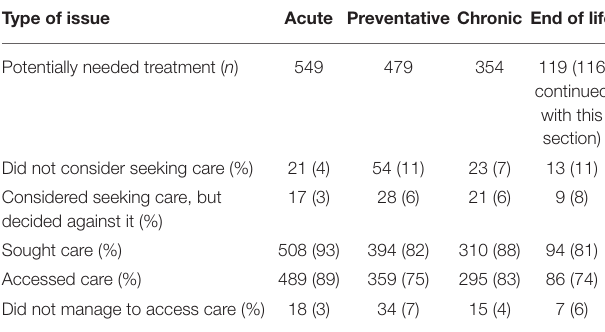
TABLE 3 | Management tools/ methods for managing health of dogs with chronic health conditions. Method